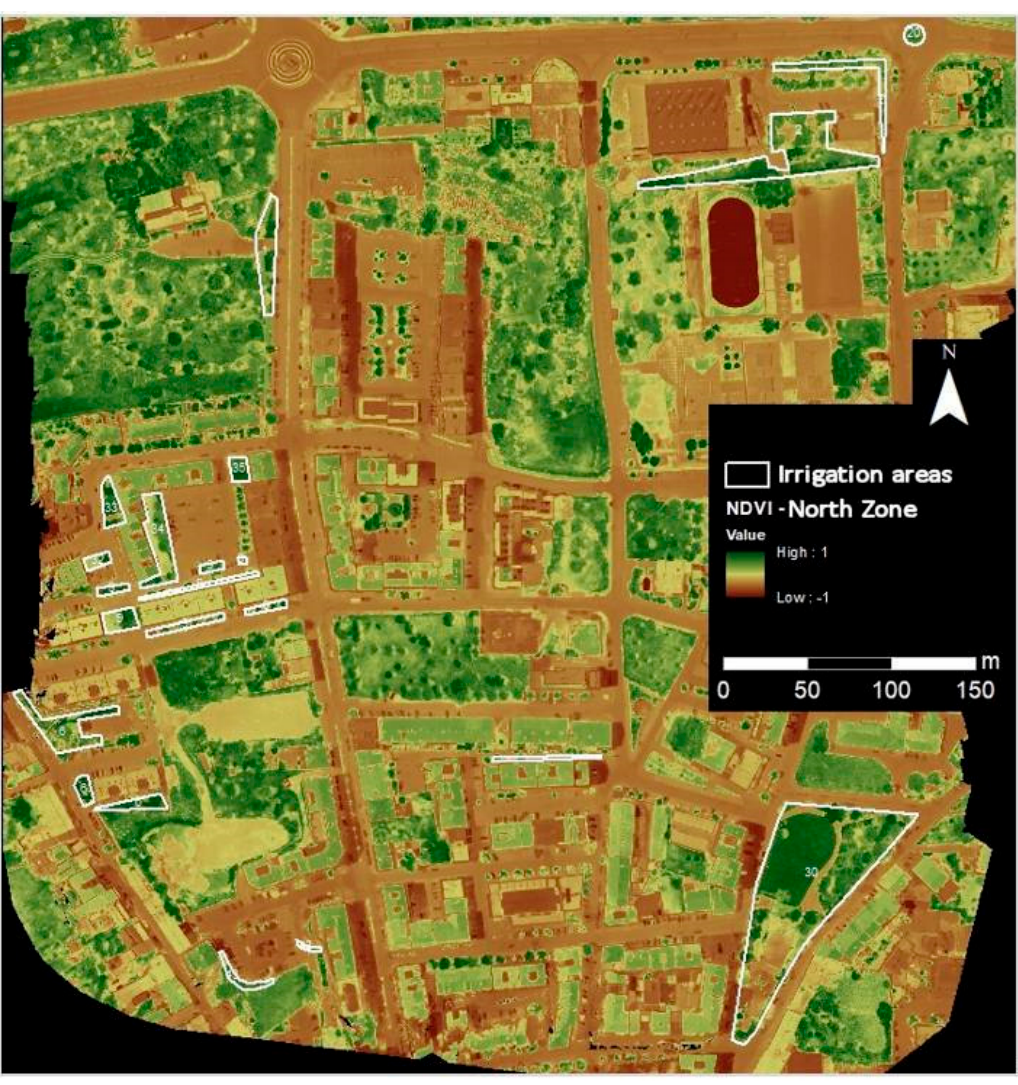
Figure 6. Modified normalized difference vegetation index (NDVI) from the urban green areas (white contours) maintained by the municipality of São Brás de Alportel.